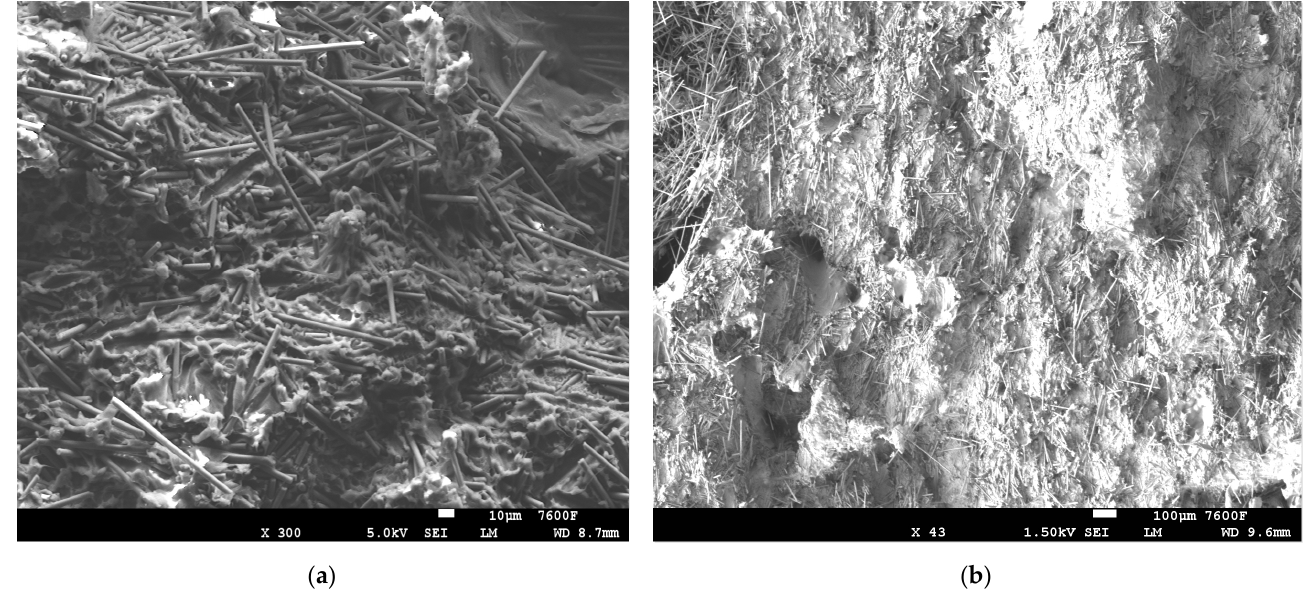
Figure 4. SEM images: ( a ) 5% CF/Plasma PE and ( b ) 10% CF/plasma PE combinations.